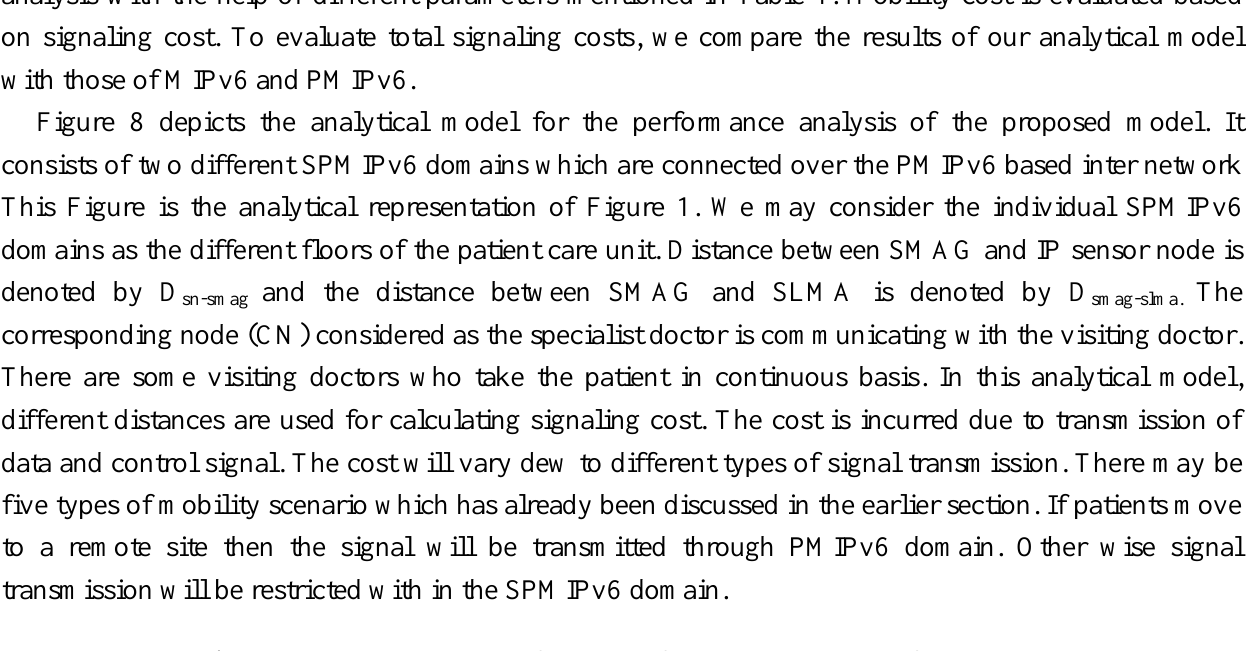
Figure 8. Analytical model for the performances analysis of